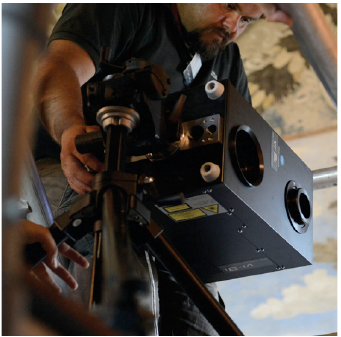
Figure 8. MINOLTA, VIVID 9i